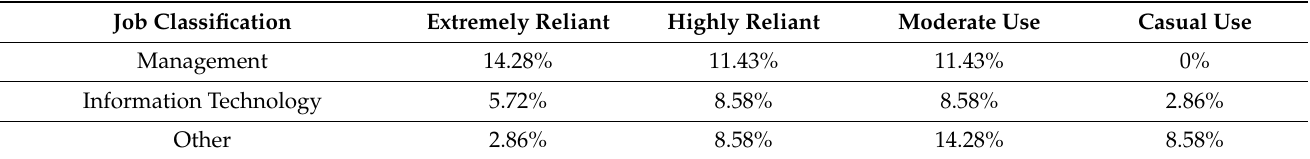
Table 5. Job role classification relationship with reliance on BYOD strategies. Job Classification Extremely Reliant Highly Reliant Moderate Use Casual Use Management